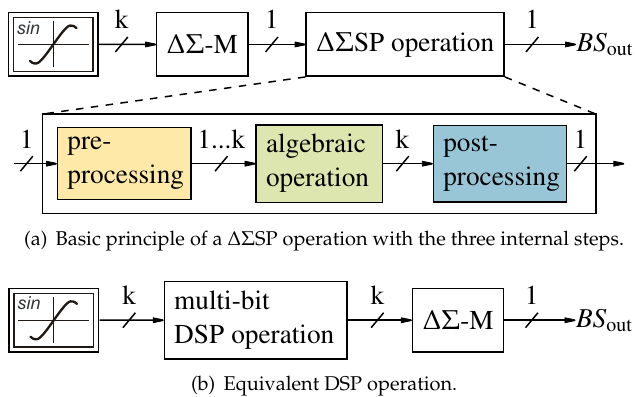
Figure 4. Basic principle of a ∆Σ SP operation with three internal steps and the equivalent DSP